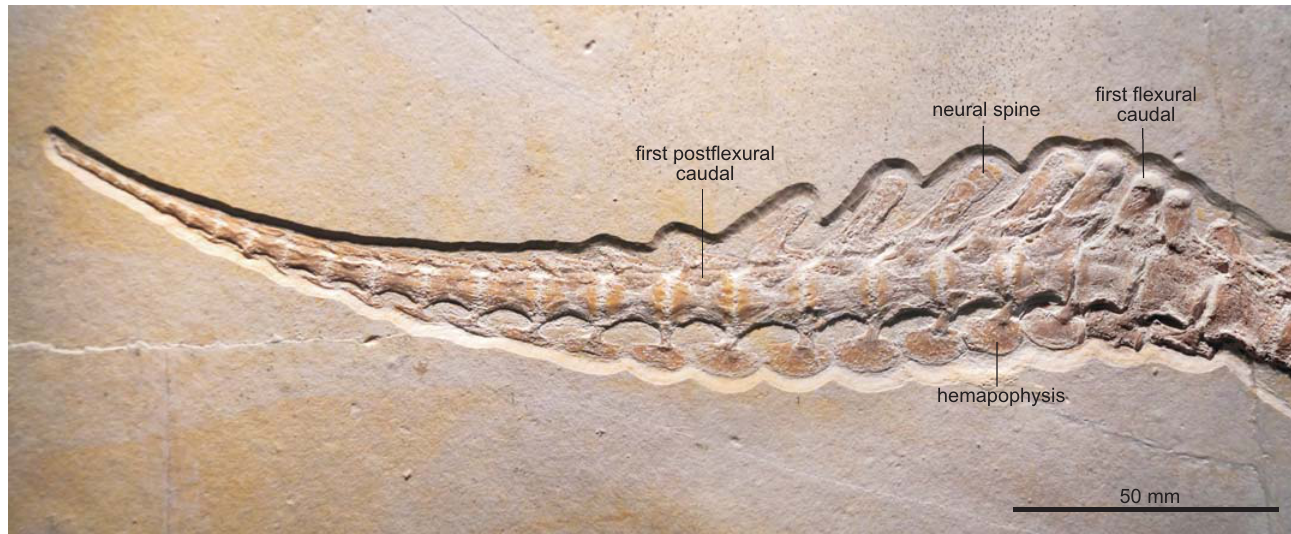
Fig. 6. Metriorhynchid thalattosuchian Cricosaurus bambergensis sp. nov. (NKMB-P-Watt14/274) holotype, late Kimmeridgian of Wattendorf (southern Germany). Distal part of the tail showing the flexural and postflexural